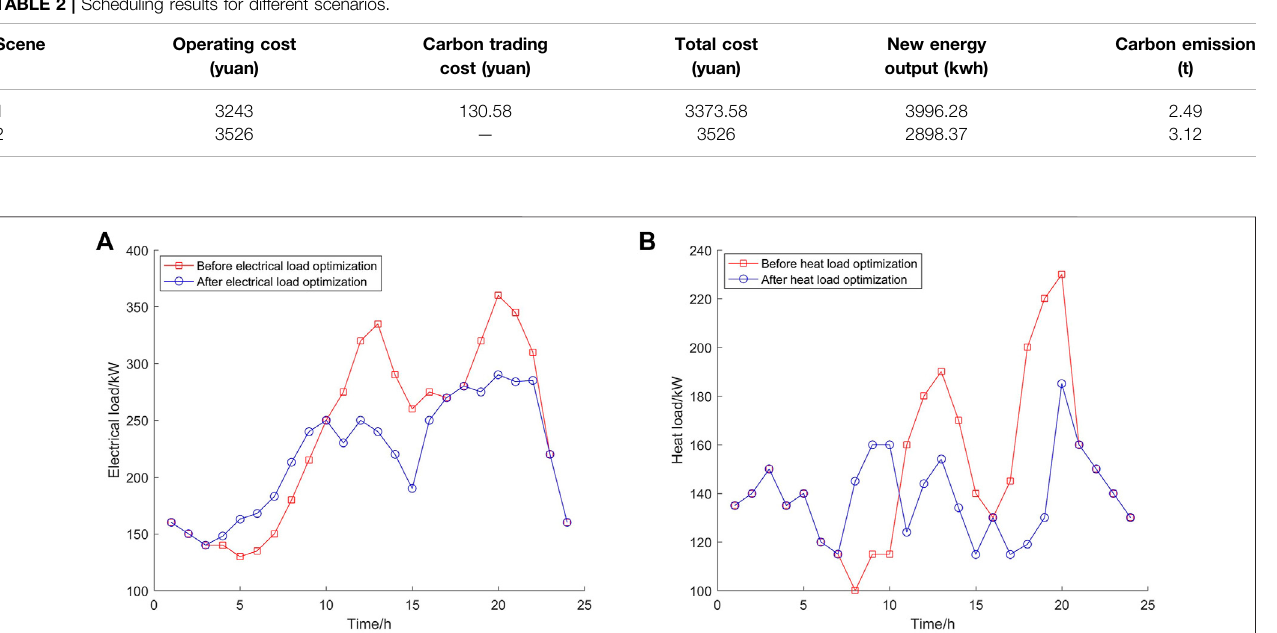
Frontiers in Energy Research |